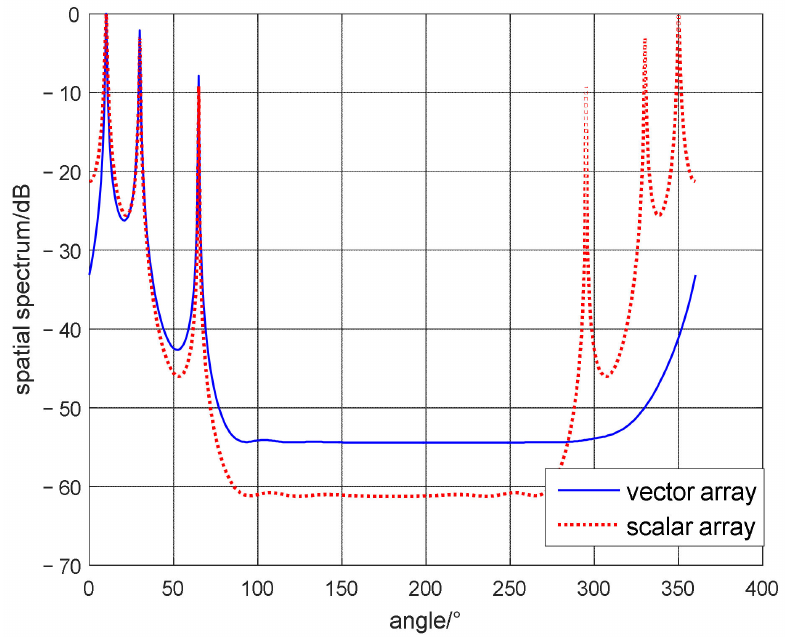
Figure 4. The different of scalar and vector array localization